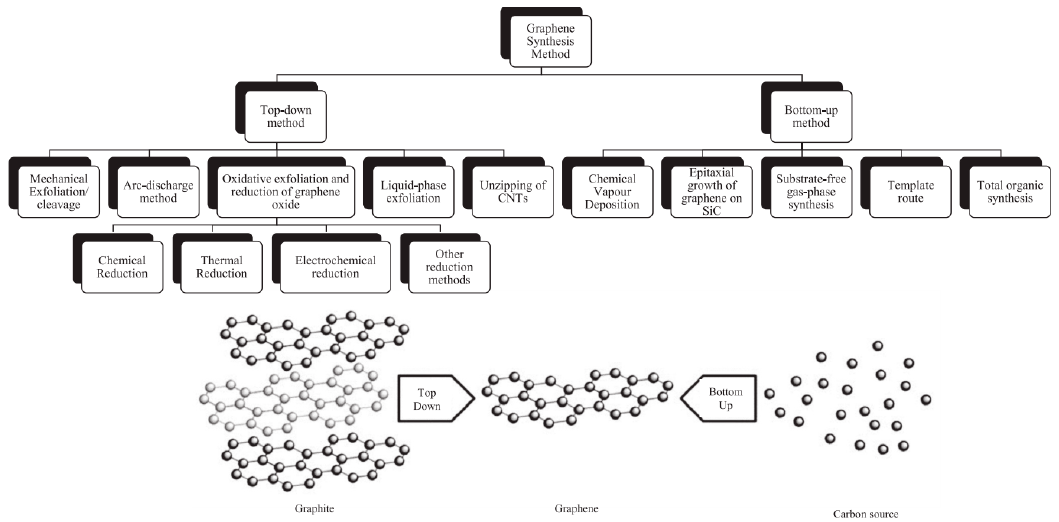
Figure 4. Production techniques of graphene materials. Reproduced with permission from Reference [119].